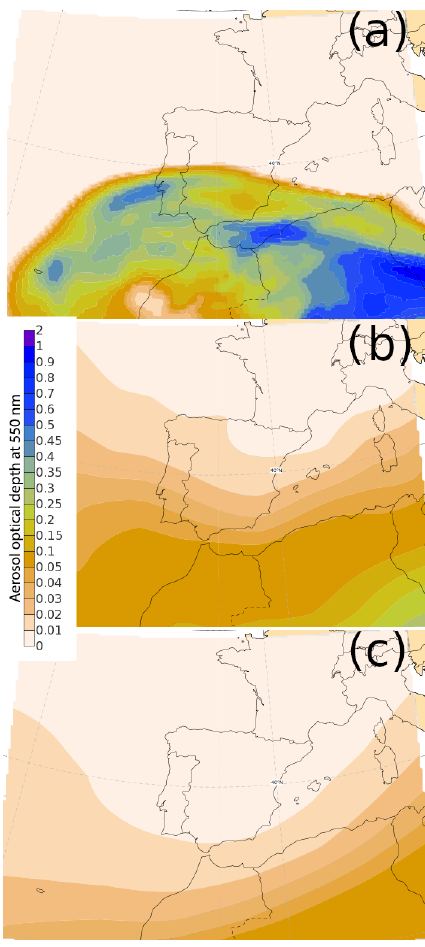
Figure 3. 24h average global radiation (Wm − 2 ) from 24h fore- casts starting 00:00UTC on 21 February 2017: CAMSNRT (a) and Tegen (b) experiments (upper colour scale) and their difference ( c , lower colour scale). Locations of Badajoz and Madrid are marked with red